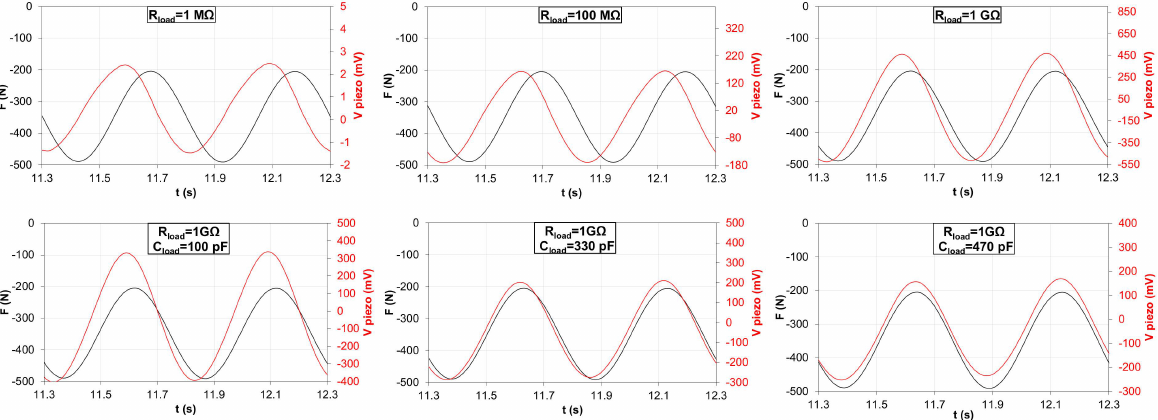
Figure 9. Piezoelectric output voltage vs. compressive sinusoidal force for different values of R load and C load